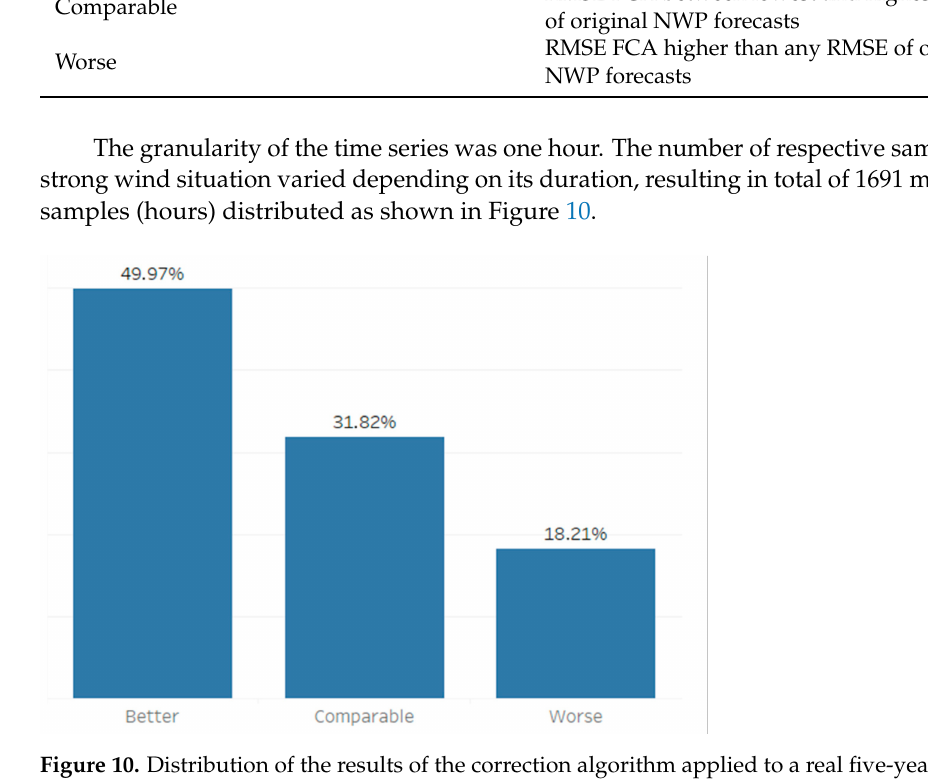
Figure 10. Distribution of the results of the correction algorithm applied to a real five-year data set from Croatian bridge